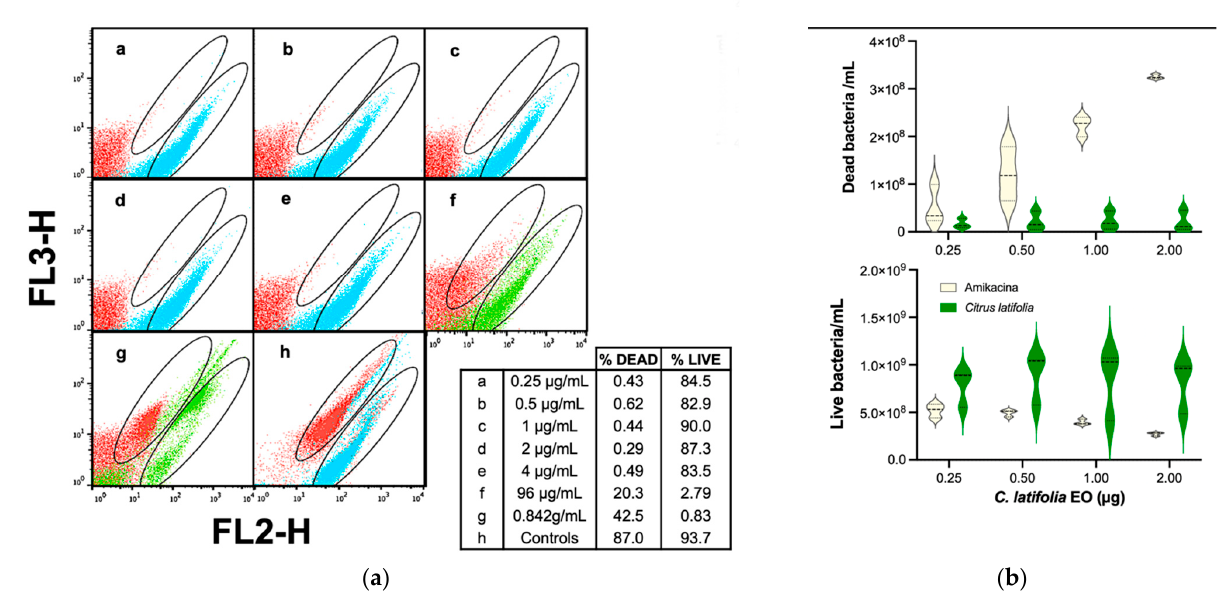
Figure 6. Evaluation of the antibacterial activity of C. latifolia EO. ( a ) Dot plot of green (FL3-H) vs red (FL2-H) fluorescence readings for several concentrations of C. latifolia oil; ( b ) Violin graphs of the quantization of cell number for some concentrations used. Student’s t -test: p = 0.001 and p = 0.037 for live and dead bacteria vs. amikacin, respectively.